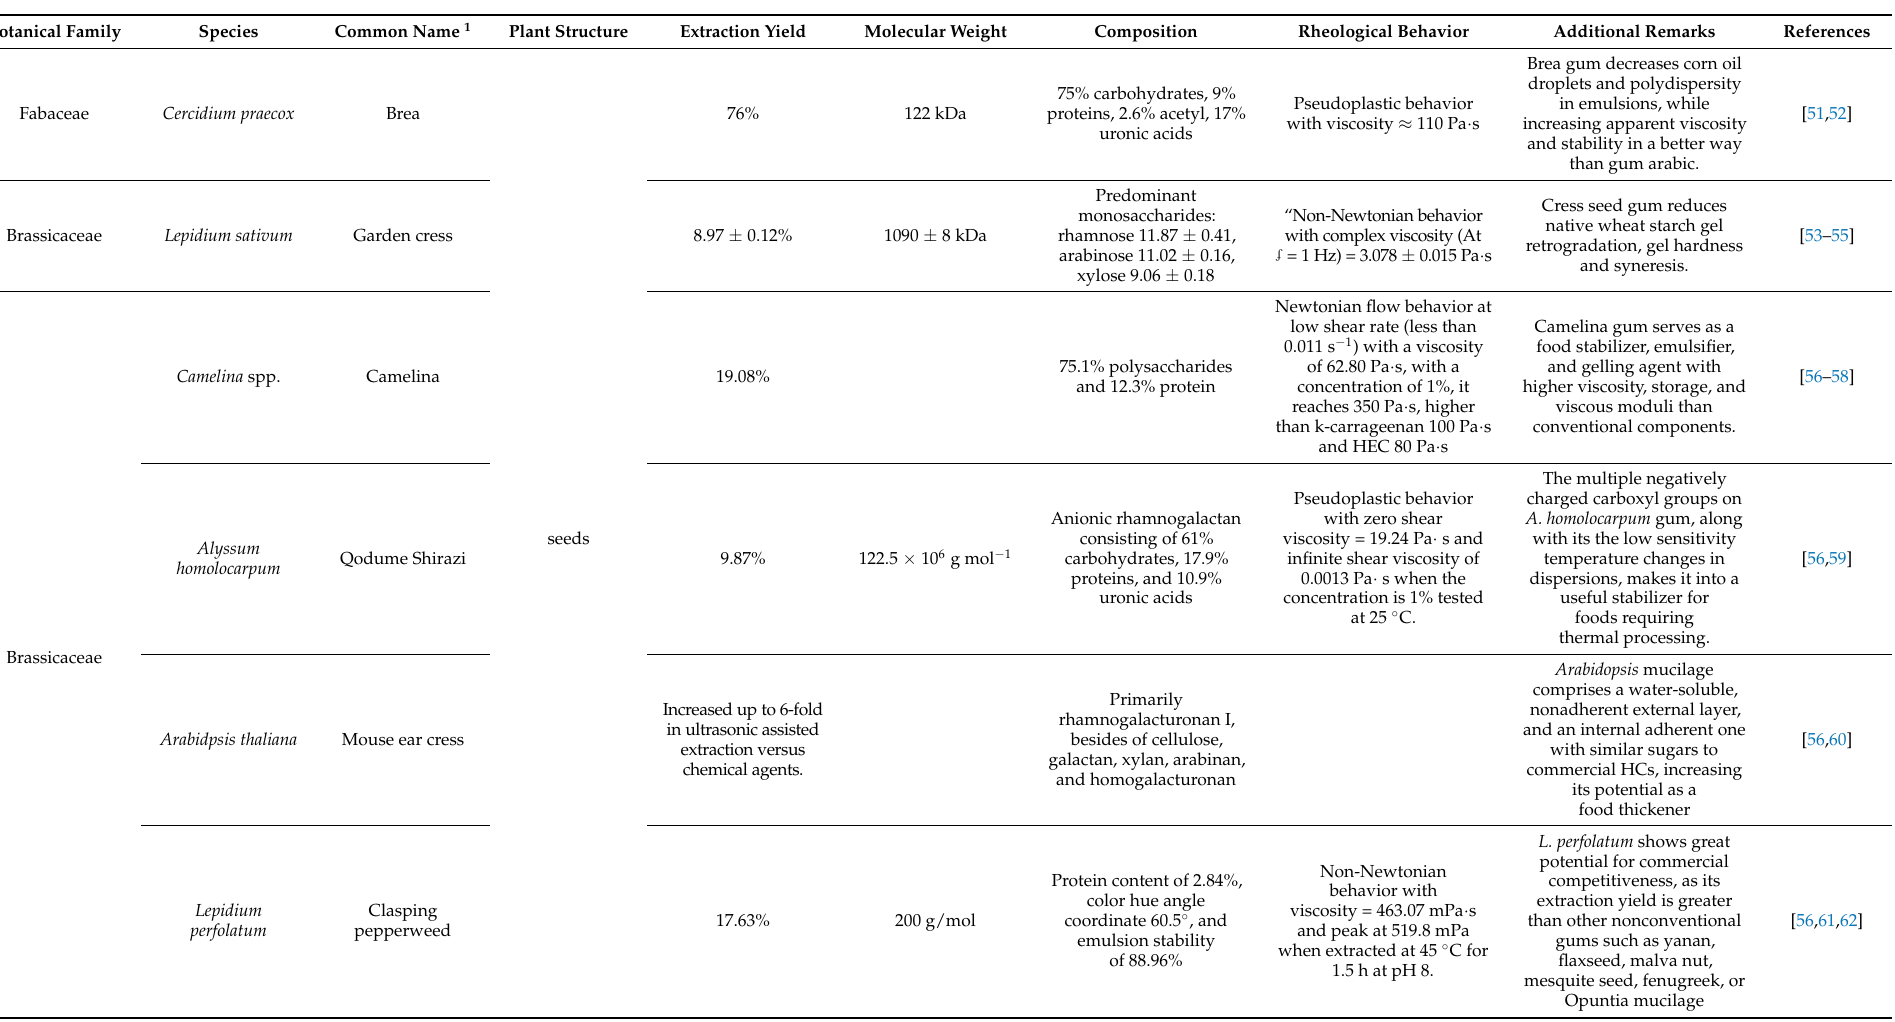
Table 1. Botanical origin, compositional, and functional properties of some nonconventional hydrocolloids.